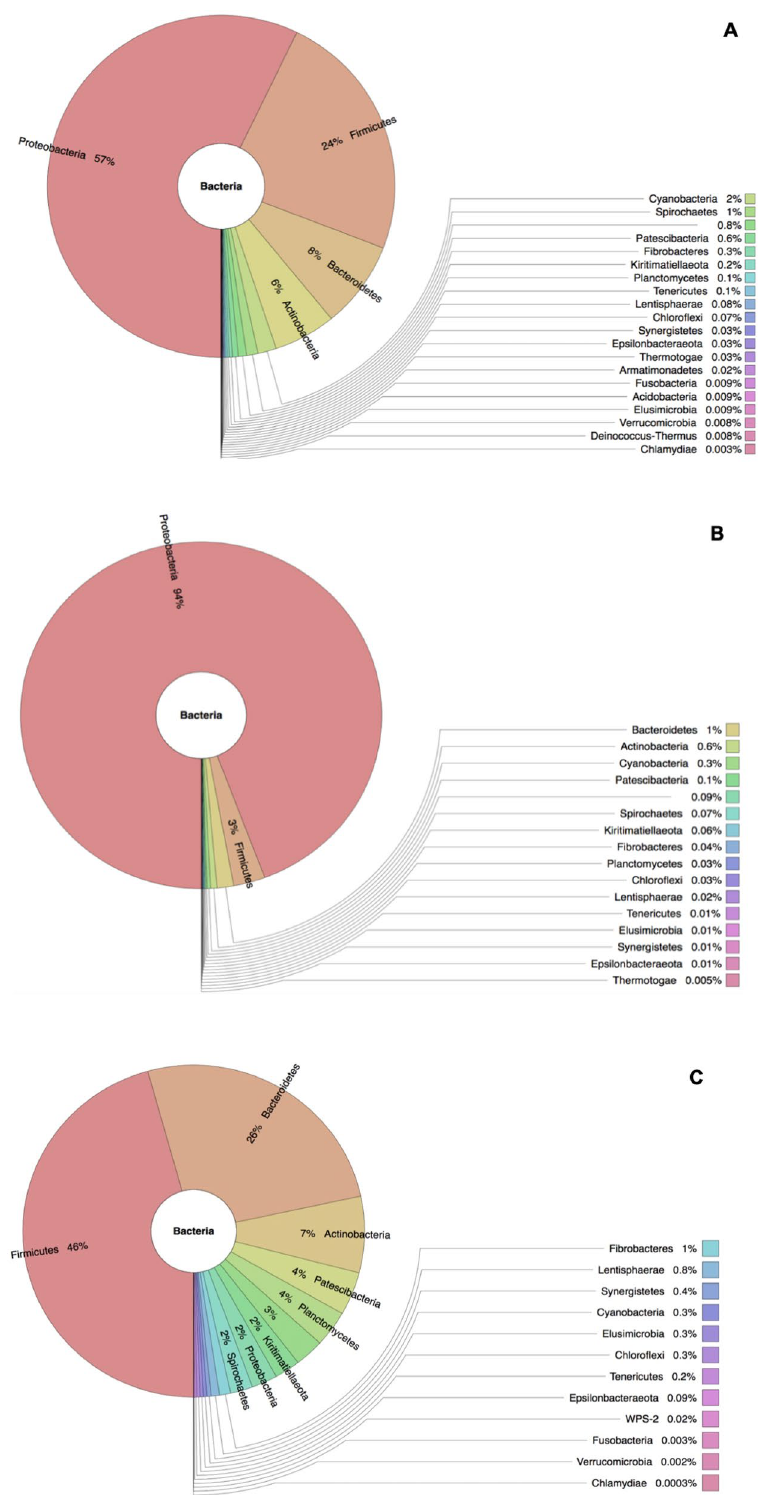
Figure 2. Krona plot for taxonomic abundance of the adult male ( A ), female ( B ) H. contortus and Abomasum ( C ) microbiome at the phylum level. Data represent average values from pooled